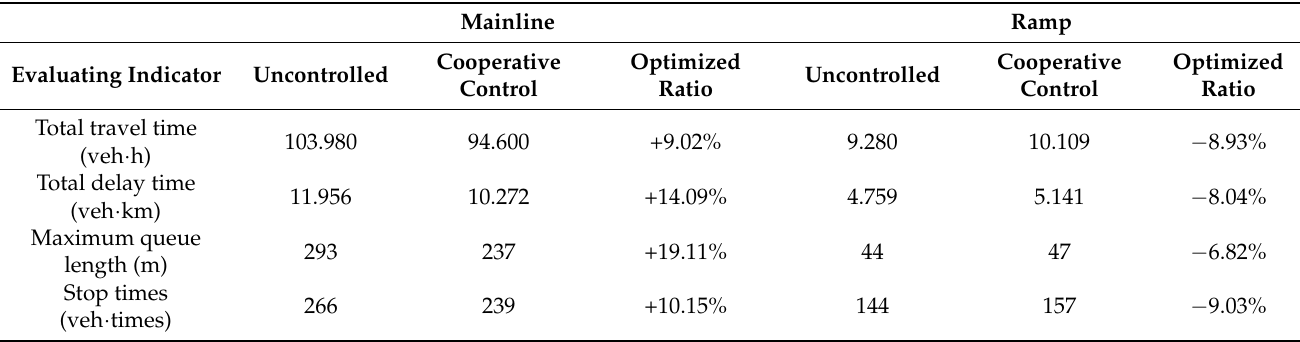
Table 7. Comparison of operation efficiency before and after control of merging area 1.